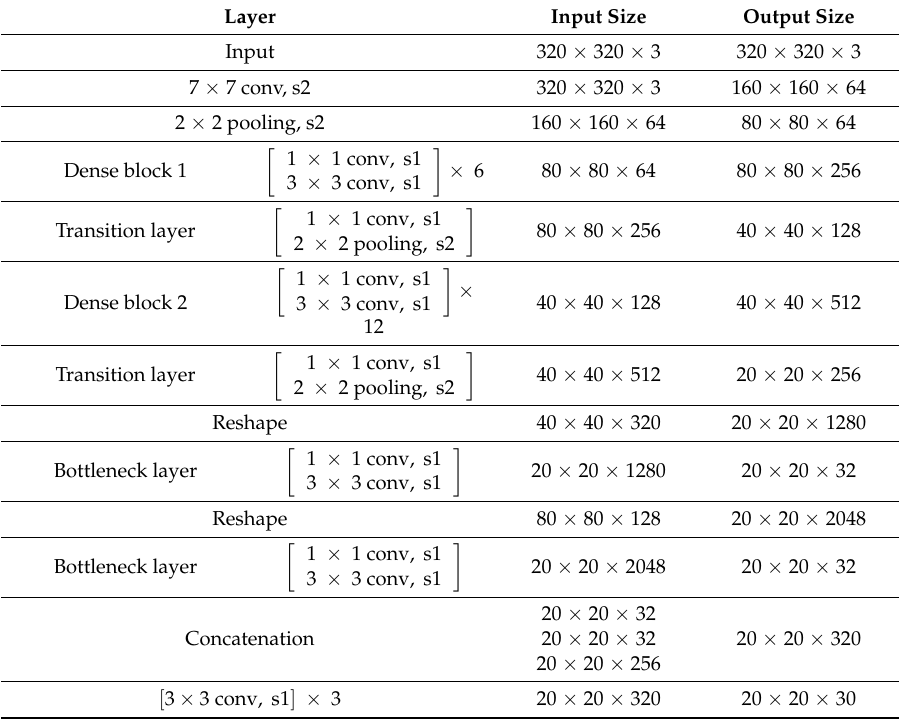
Table 3. Architecture of lightDenseYOLO for marker detection. Each conv layer is the sequence of batch normalization (BN), rectified linear unit (ReLU), and convolution layer. s1 and s2 present stride by 1 and 2 px,